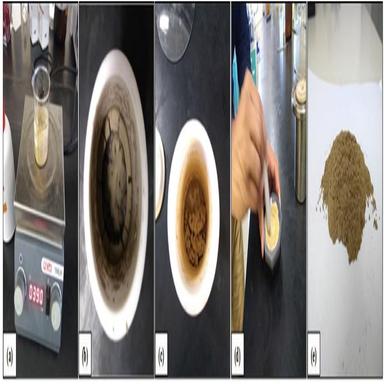
Pictorial representation of synthesis mechanism of STEAM1 and STEAM2 additives: (a) uniform mixing of the reagents on magnetic stirrer; (b) solution paste obtained after three days of oven drying; (c) drying of paste at room temperature; (d) breaking of paste into powder form using mortar and pestle arrangement; (e) STEAM1 or STEAM2 additive.